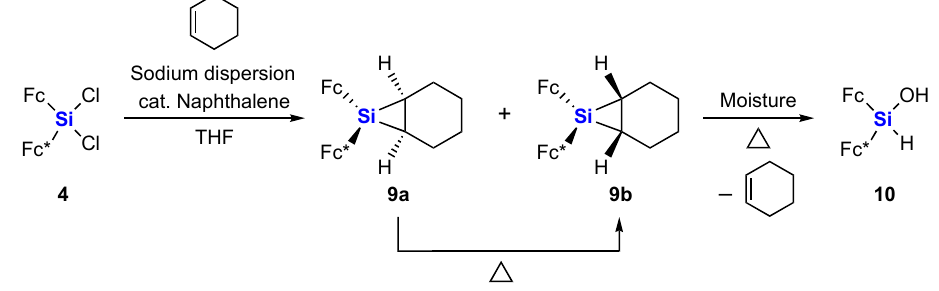
Scheme 3. Synthesis of bis(ferrocenyl)siliranes 9a and 9b .